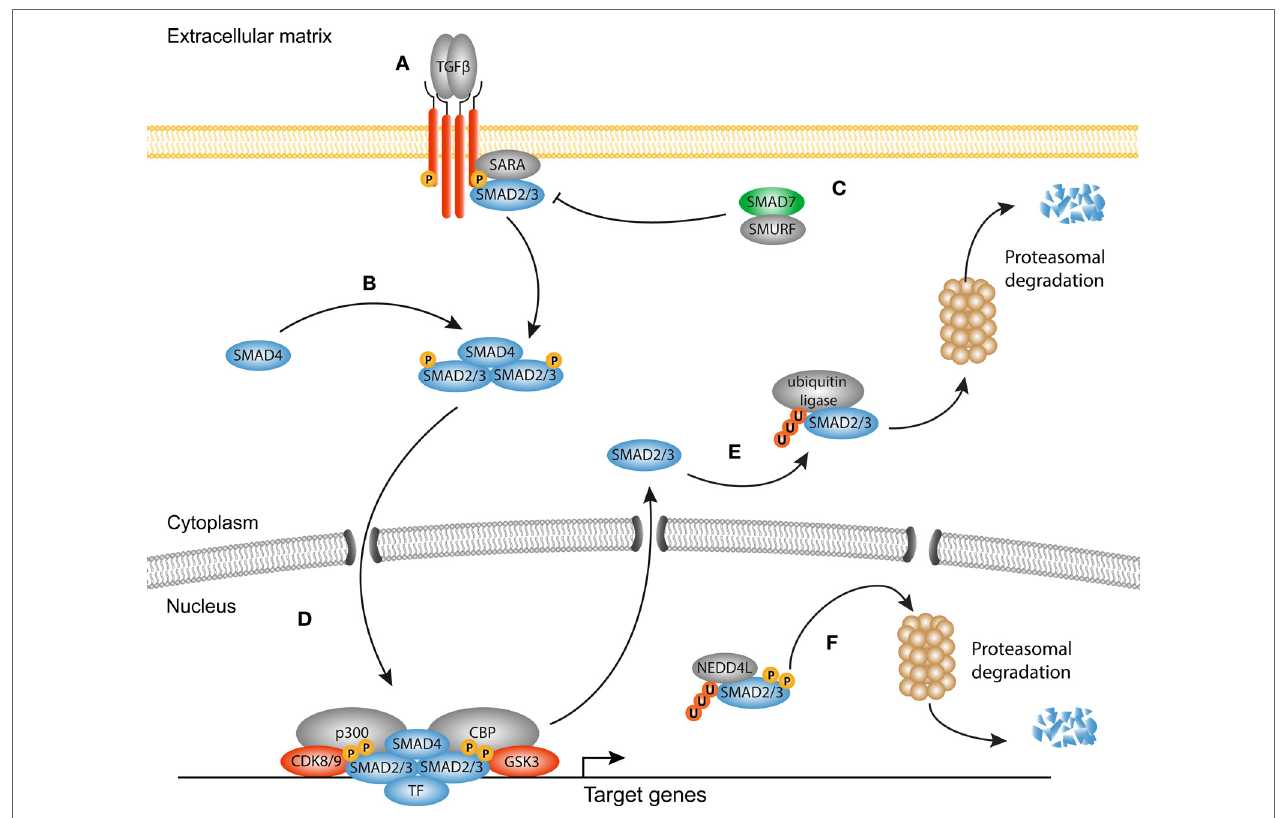
FiGURe 1 | Canonical TGF- β signaling in fibrosis . (A) Transforming growth factor- β (TGF- β ) homodimers engage the type II receptors, which phosphorylate and form a heterotetrameric complex with two type I receptors and additional Smad-binding proteins such as SARA. The signaling domain of the type I receptor mediates phosphorylation and activation of Smad proteins. (B) Smad4 associates with phosphorylated Smads to form an active heterotrimeric complex. (C) The inhibitory Smad7 together with Smad-specific E3 ubiquitin protein ligases (Smurf) inhibits the receptor complex by targeting it for ubiquitination and proteasomal